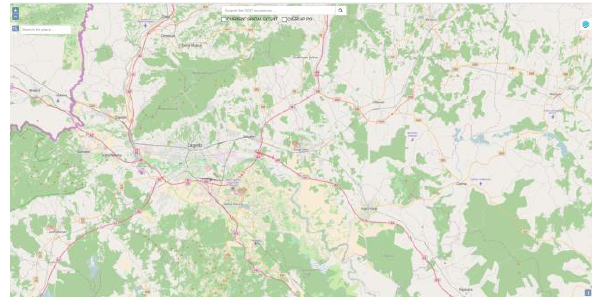
Figure 8. GUI of Bolegweb Geospatial Portal of OGC Resources 9 .